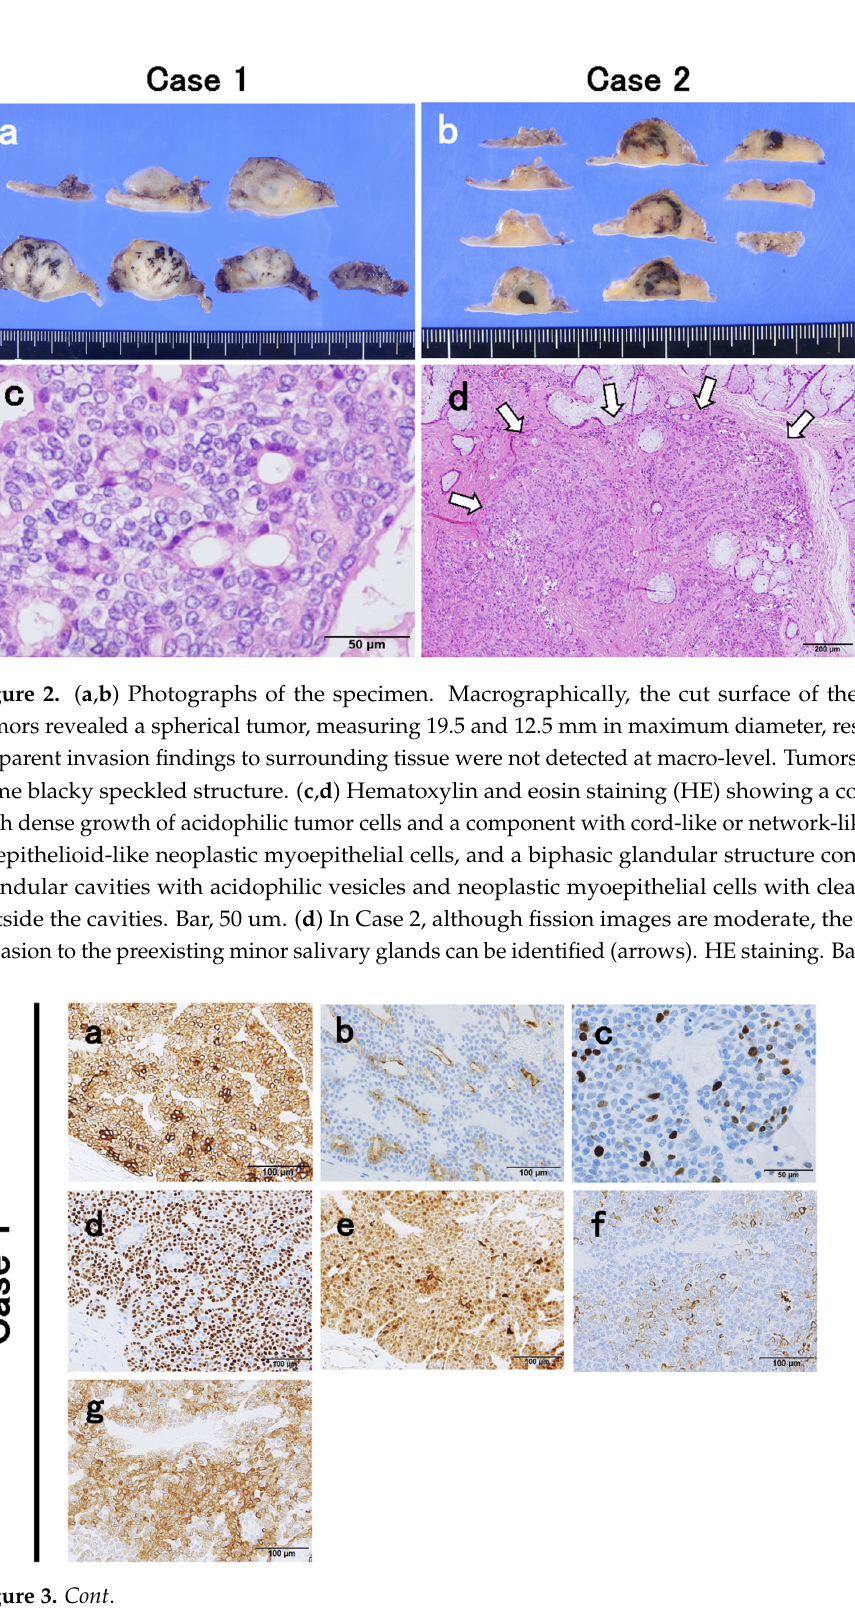
Figure 3. Immunohistochemical pattern of the present cases with epithelial-myoepithelial carci- noma. ( a , h ) The tumor was diffusely positive for AE1/AE3. ( b , i ) Glandular duct-forming cells were positive for epithelial membrane antigen (EMA). ( c ) Ki-67 showed active fission images and a high Ki-67 labeling index (10.6%). Neoplastic myoepithelial cells were positive for ( d , k ) p63, ( e , l ) S-100, ( f , m ) α -smooth muscle actin ( α -SMA), and ( g , n ) Calponin. In case 2, ( m ) Tumor nests were diffusely positive for S-100 protein. ( j ) Ki-67 labeling index was low (3.8%). 3. Materials and Methods Review of Literature We searched the PubMed database for English literature pertaining to EMCs of the MSGs using the keywords “epithelial-myoepithelial carcinoma” and “minor salivary gland” (www.ncbi.nlm.nih.gov/pubmed). Literature published between January 2000 and December 2020, with well-written description of disease condition, treatment, clinical course, histopathological analysis and findings including IHCs, and prognosis were